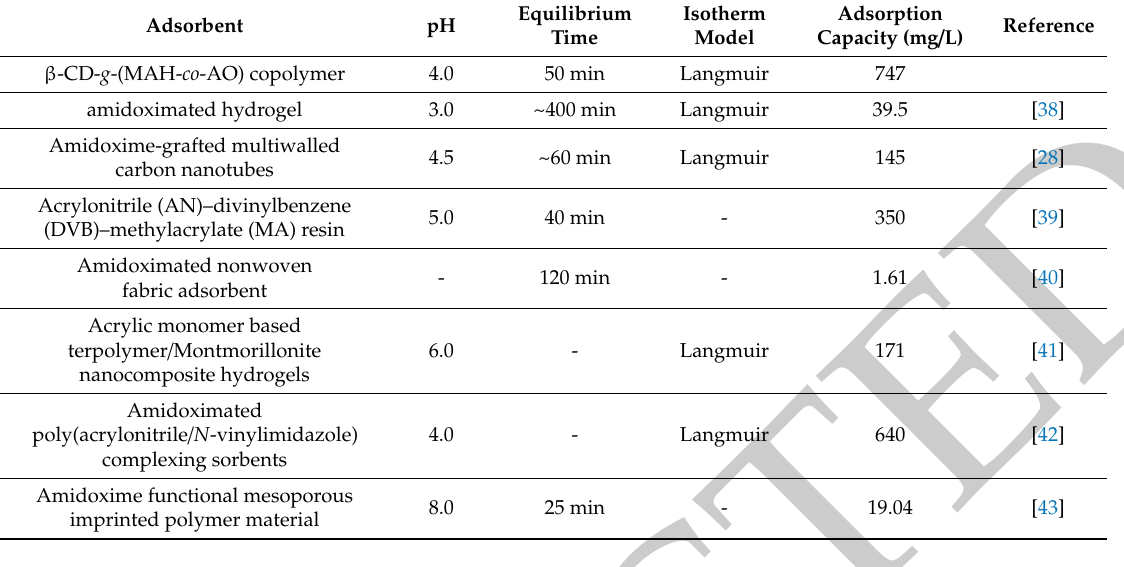
Table 4. Compared of uranium adsorption by amidoxime-functionalized materials.